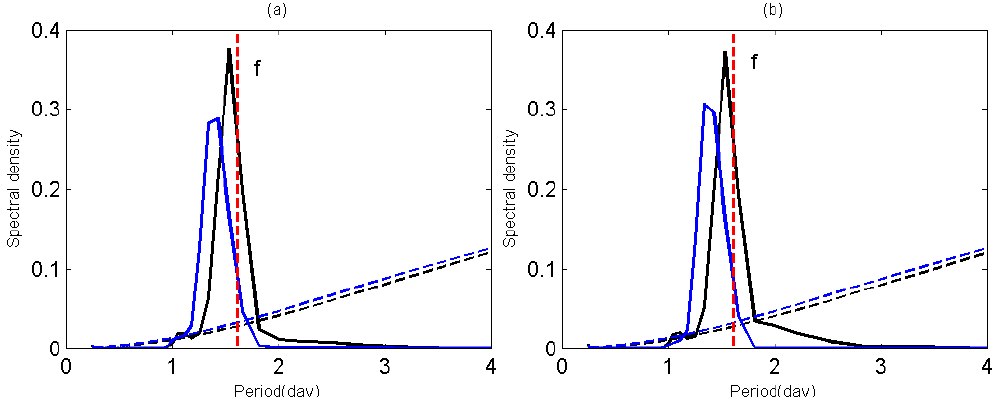
Figure 7. The power spectrum of zonal velocity (a) and meridional velocity (b) derived from the mooring (black line) and GLBu0.08 (blue line). The dashed black and blue line shows 95% confidence levels, while the dashed red line represents the local inertial period. The tide effects have been removed in the mooring